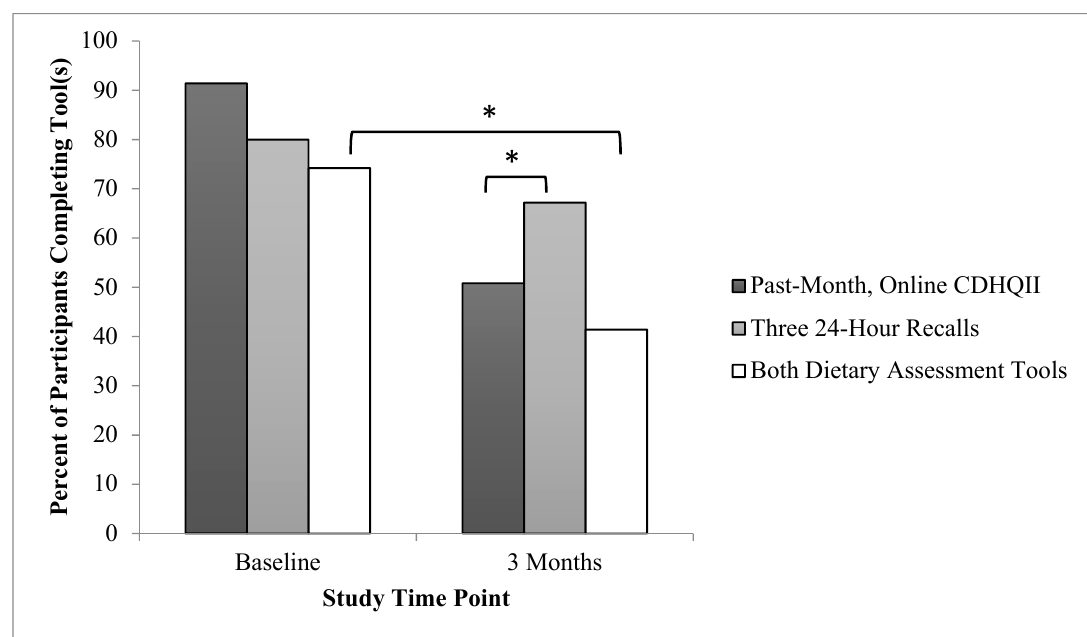
Figure 1. Proportion of participants completing dietary assessment tools. * p < 0.05